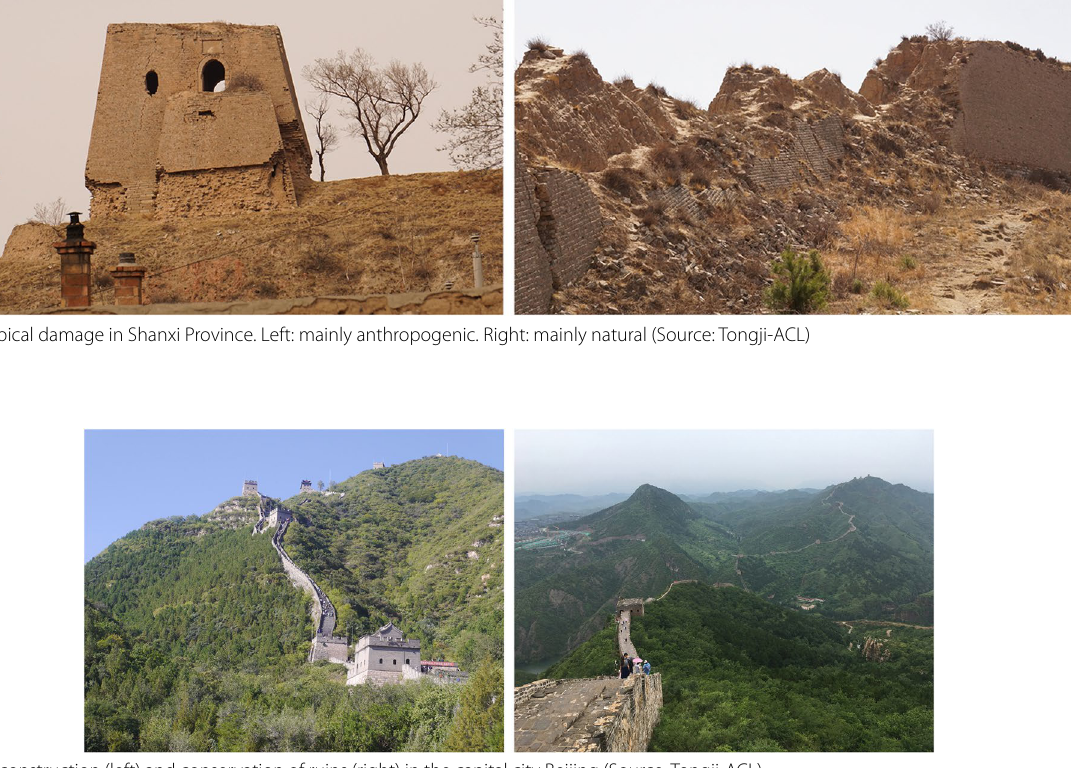
Fig. 4 Reconstruction (left) and conservation of ruins (right) in the capital city Beijing (Source: